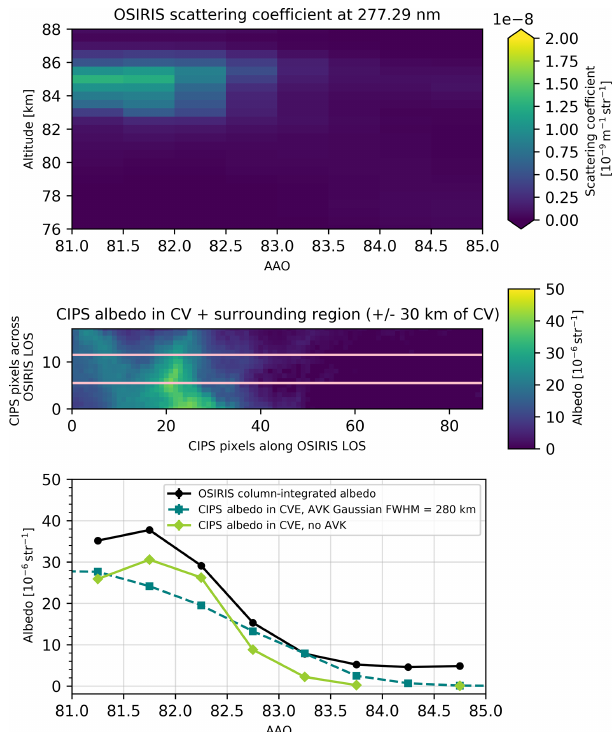
Figure 10. As in Fig. 8, but for OSIRIS orbit 51646 and CIPS orbit 17965. The coincidence occurs at latitude 79 ◦ N and longitude 357 ◦ at